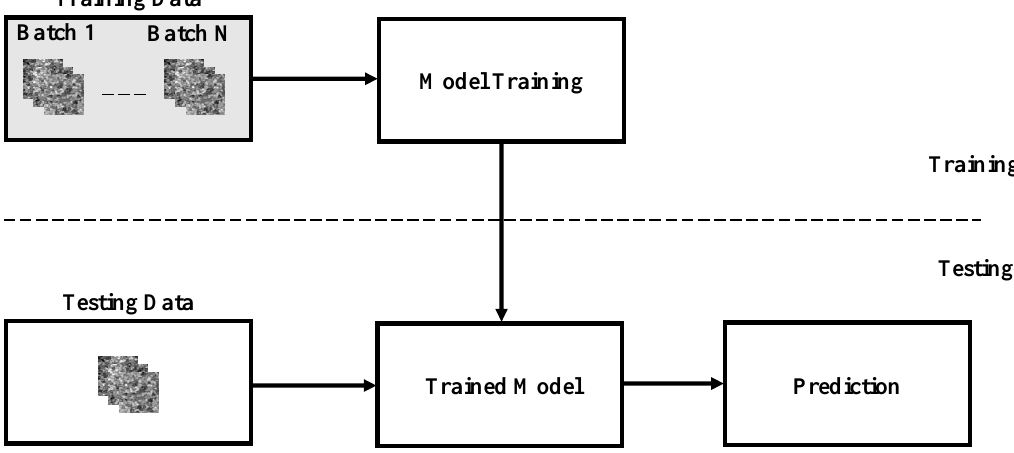
Figure 5. A flowchart of the training and testing